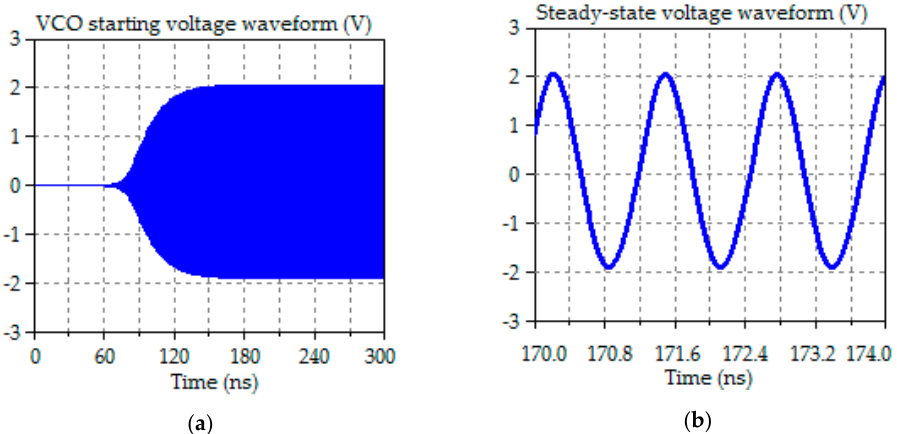
Figure 12. ( a ) Voltage-controlled oscillators (VCO) starting voltage waveform when V c = 1 V; ( b ) VCO steady-state voltage when V c = 1 V.